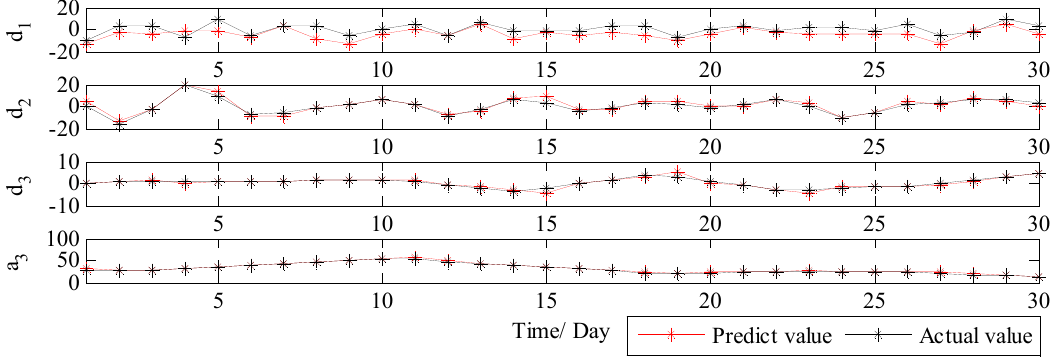
Figure 9. The forecast results of each subset by WT-DE-BP model (Wuhan).